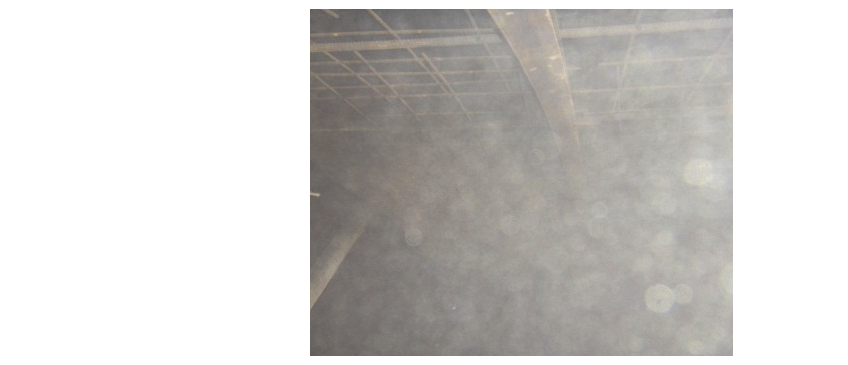
Figure 13: Field dry-mix shotcrete.